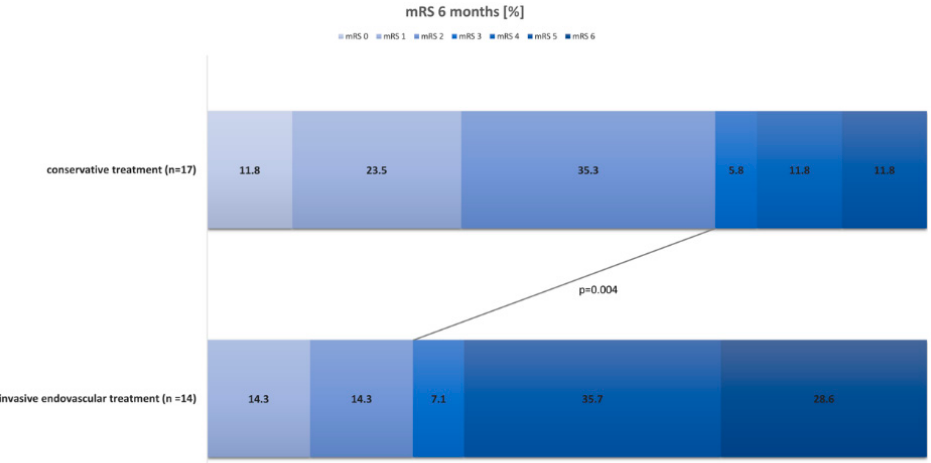
Figure 2. Column bars showing the proportions of patients regarding the mRS after 6 months. The first column bar represents the conservative treatment arm, whereas the second bar displays the invasive endovascular treatment arm. The line connects the mean mRS values of both groups and the p -value represents the result of the independent t -test .